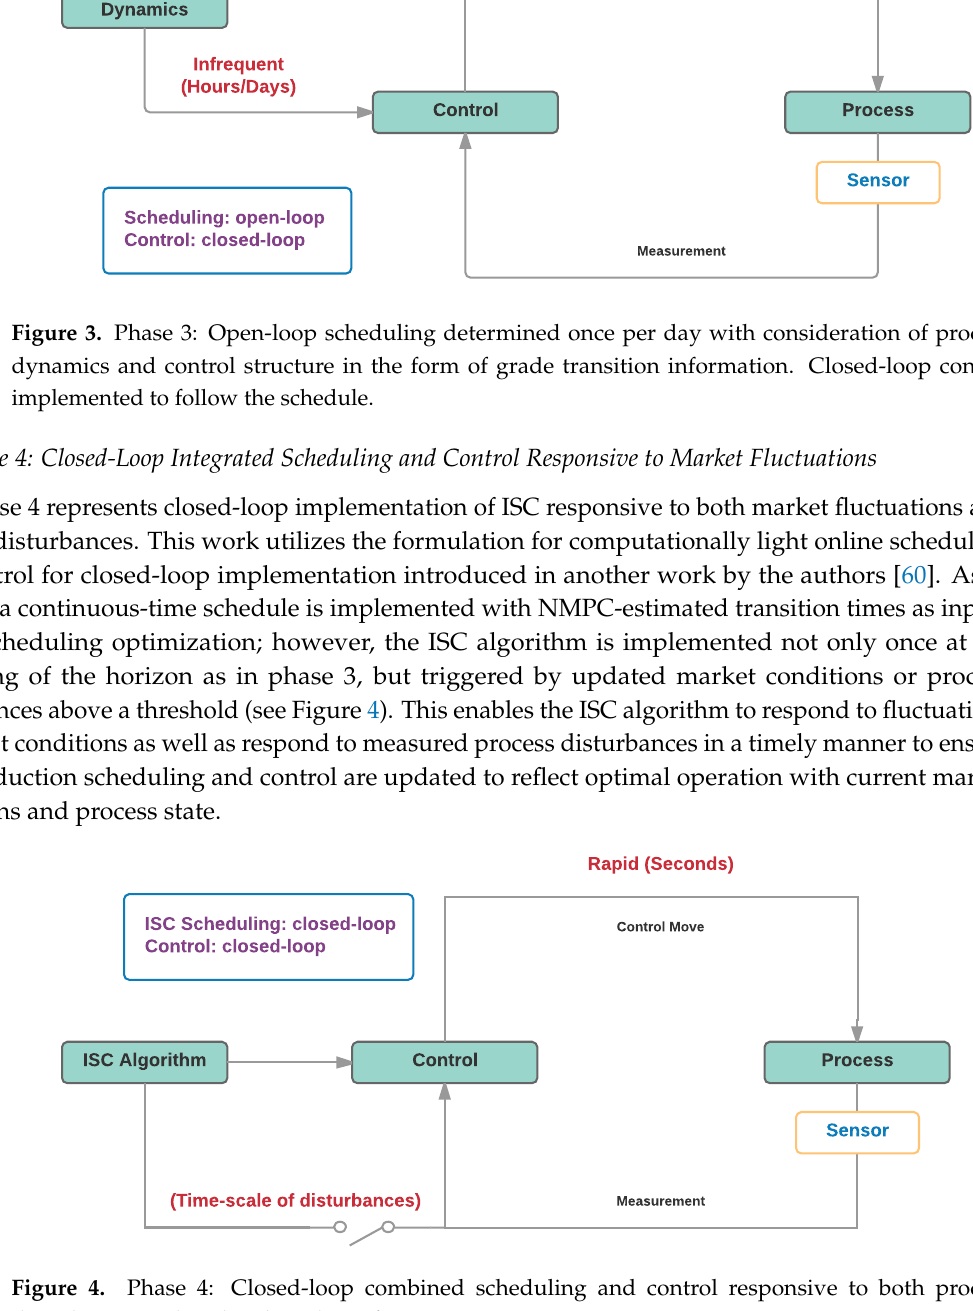
Figure 4. Phase 4: Closed-loop combined scheduling and control responsive to both process disturbances and updated market